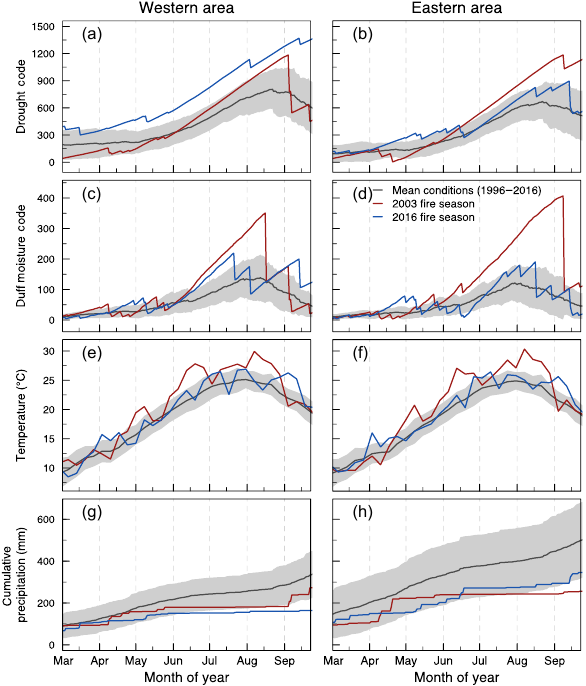
Figure 7. Seasonal dynamics of weather conditions and drought in- dices during the 2003 and 2016 fire seasons in the western and east- ern areas. Mean (black line) and standard deviation (shaded area) for the period from 1996 to 2016 are also indicated. All variables are shown at daily timescale expect temperatures that were aver- aged at weekly timescale for clarity.